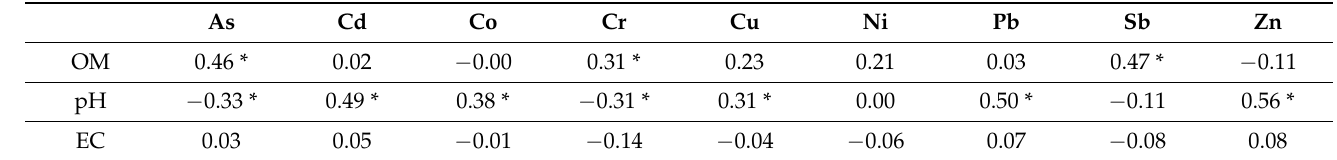
Table 5. Spearman’s rank correlation coefficients of selected properties and PTEs contents in the studied